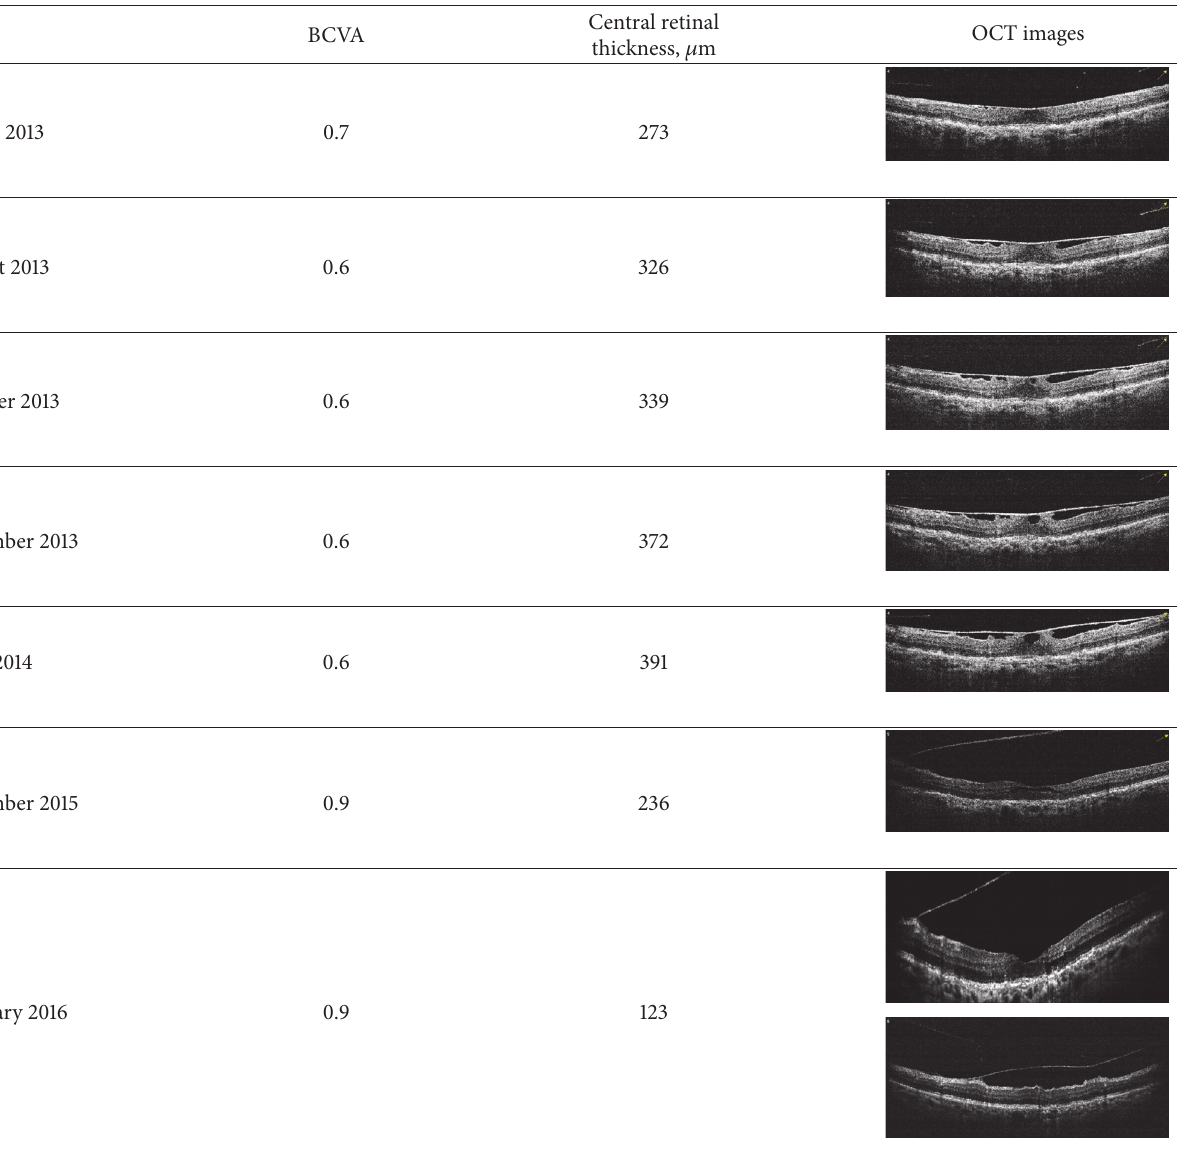
Table 1: Best corrected visual acuity (BCVA), central retinal thickness, and OCT images of the patient’s left eye during the three-year